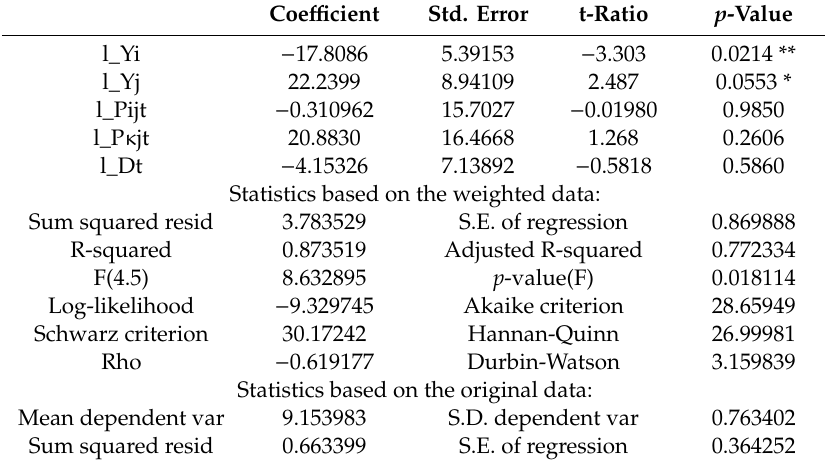
Table 6. FGLS estimation of Croatian tourist consumption in Hungary—general model. Model 3: FGLS, using observations 2009–2018 (T = 10); dependent variable: l_TXij; variable used as weight: